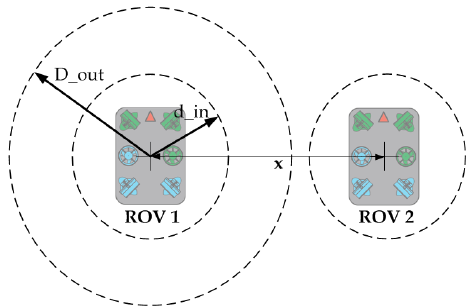
Figure 3. Defines the zone to avoid collisions between